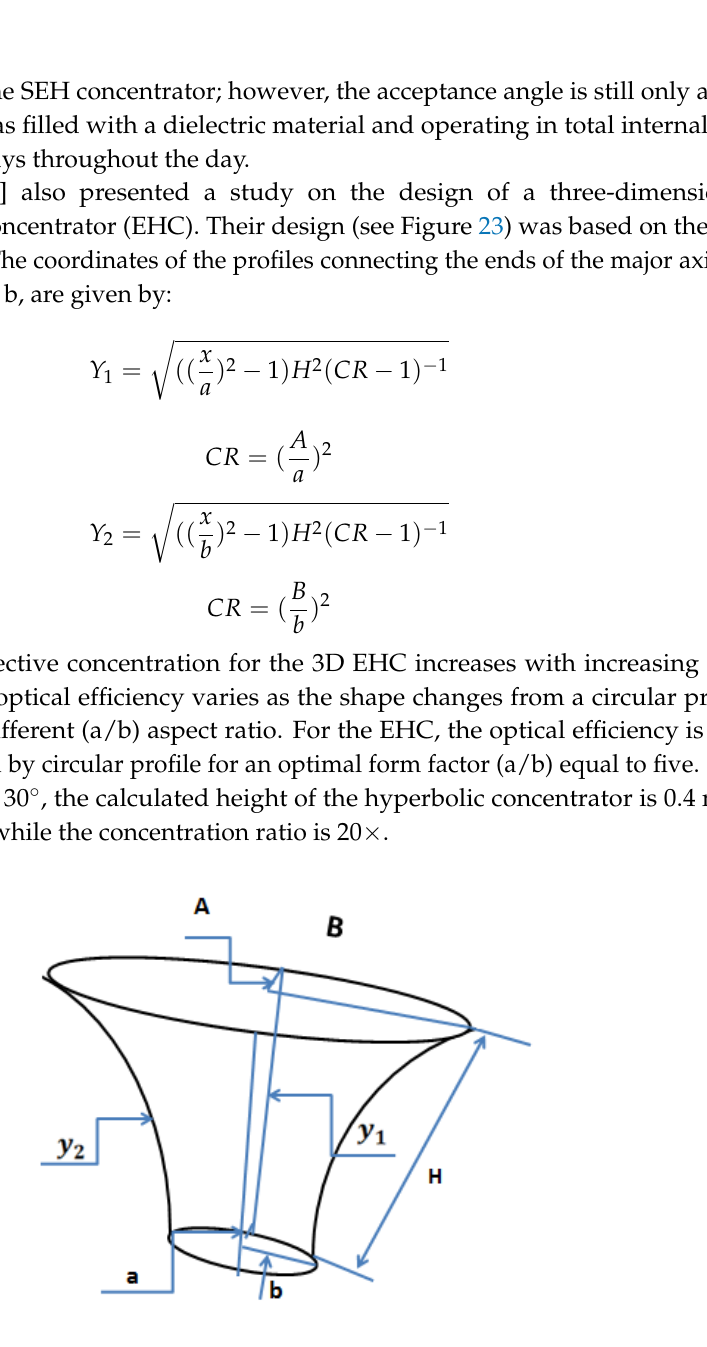
Figure 23. Geometric parameters of the hyperboloid concentrator